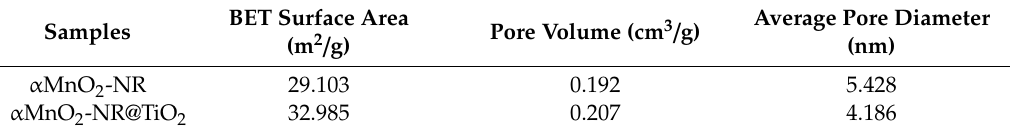
Table 1. Pore structure analysis of the sorbents.